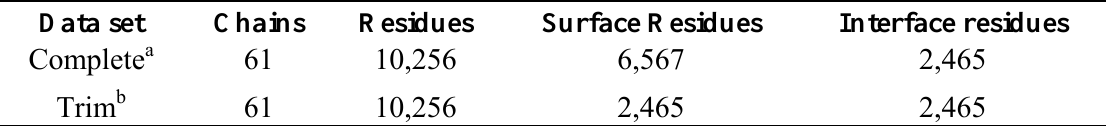
Table 3. Two types of data